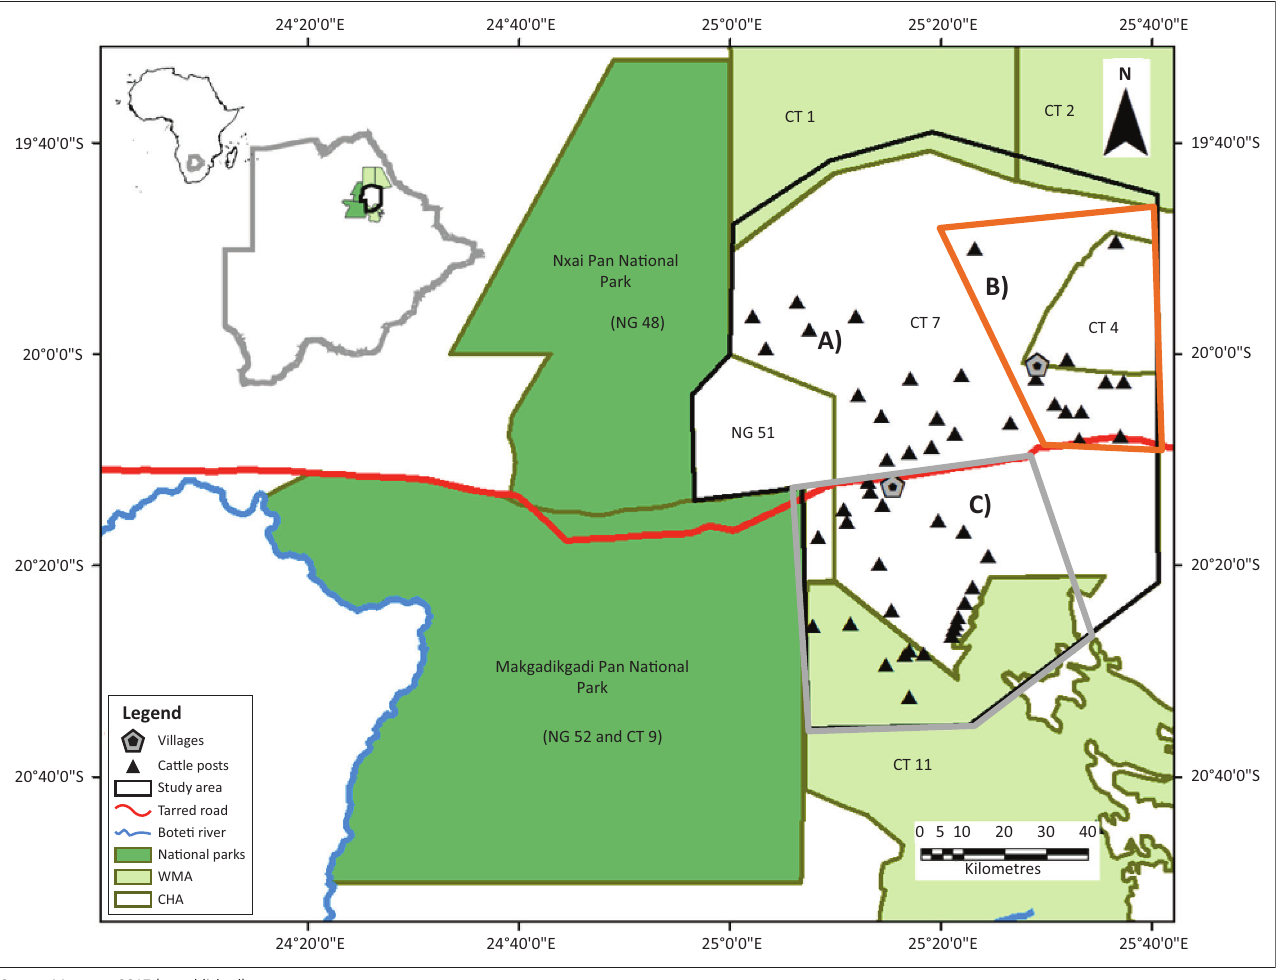
FIGURE 1: Map of the study area showing the communal area (CT 7) in relation to protected areas (national parks [Nxai and Makgadikgadi] and wildlife management areas [CT 1, CT 2 and CT 11]) and the three section division as used to group herders during the workshop. Section A is Gweta north, B is Gweta south and C is